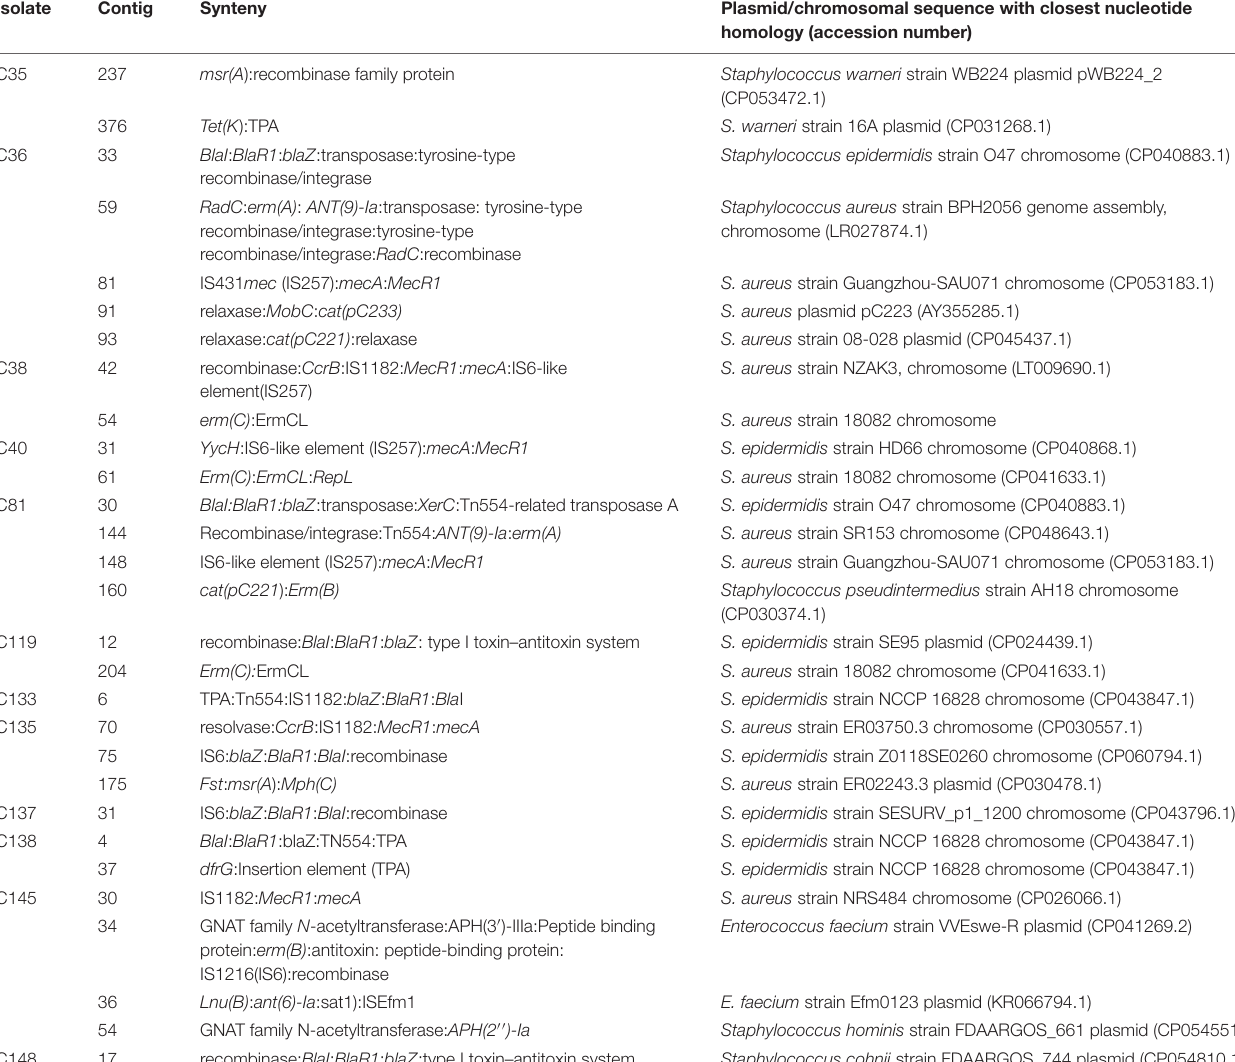
TABLE 6 | MGEs associated with antibiotic resistance genes in the MRSE strains. Isolate Contig